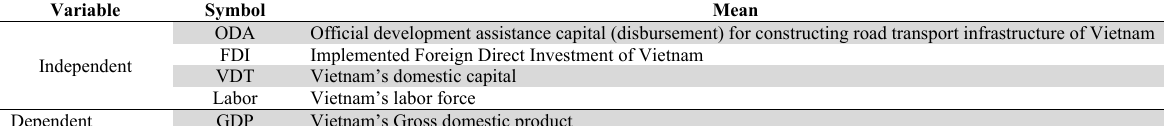
Fig.1. Research model of the impact of ODA in constructing road transport infrastructure on Vietnam's GDP Description of variables